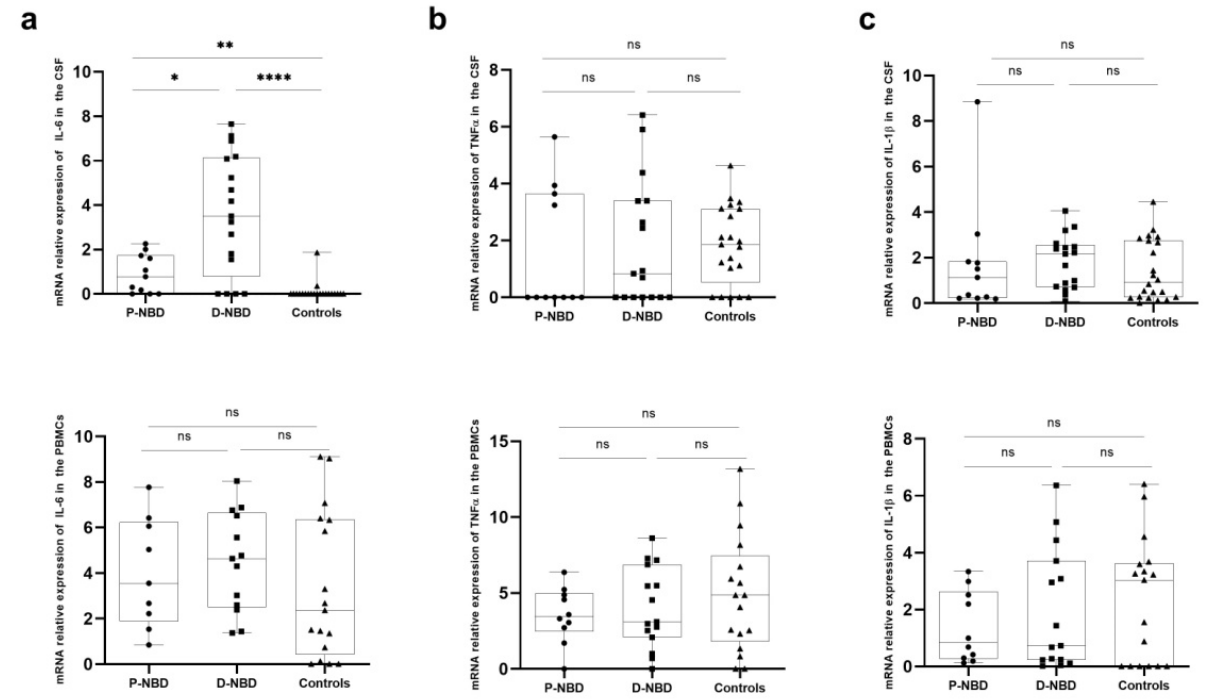
Figure 5. Boxplots represention of inflammation-related genes expression in PBMCs and CSF cells: ( a ) Representative boxplots of IL-6 expression in the PBMCs and CSF of patients and NIND; ( b ) Representative boxplots of TNF α expression in the PBMCs and CSF of patients and NIND; ( c ) Representative boxplots of IL-1 β expression in the PBMCs and CSF of patients and NIND. Statistical significance between the two groups was assessed using the Wilcoxon–Mann–Whitney test ns = non significant, * p ≤ 0.05, ** p < 0.01, **** p < 0.0001.